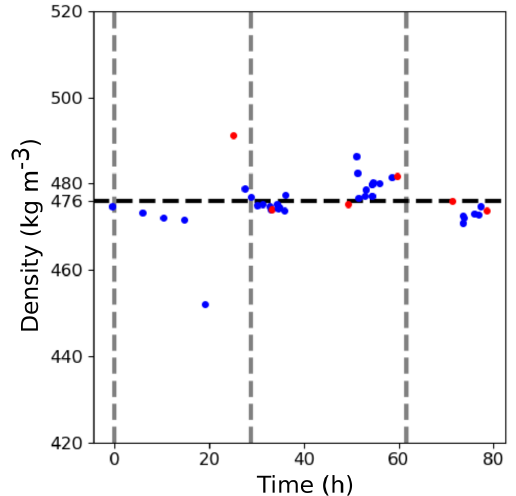
Figure 9. Density evolution: grey vertical lines represent the times of change of temperature conditions. Red dots correspond to times for which DCT information is available. The horizon- tal black dashed line represents mean density, which stays around 476kgm − 3 ( ± 5% ) . Figure 10. Specific surface area: REV estimation for different times. The vertical grey line represents the size of the REV volume taken for the remainder of the